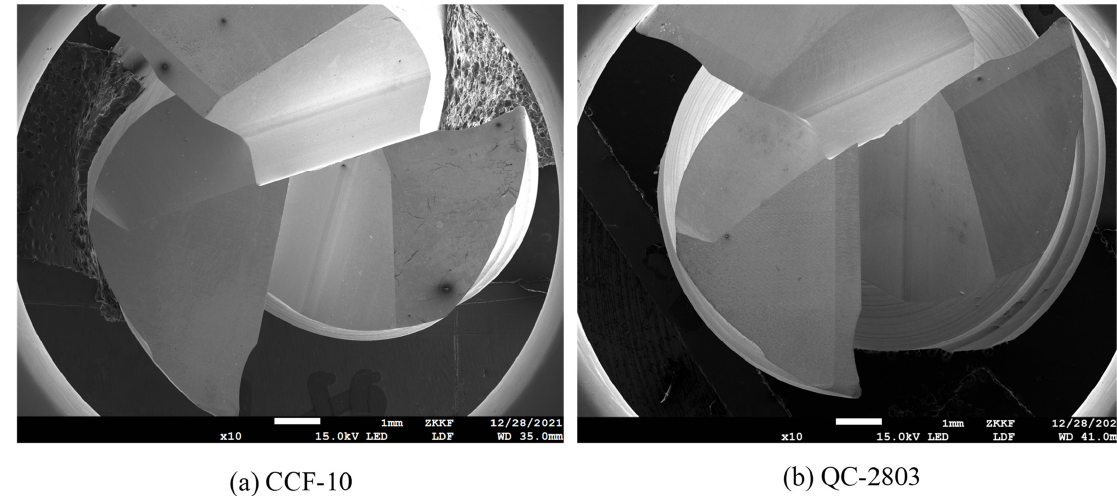
Figure 12. SEM images of wear surface of whole tool under two cutting fluid conditions.